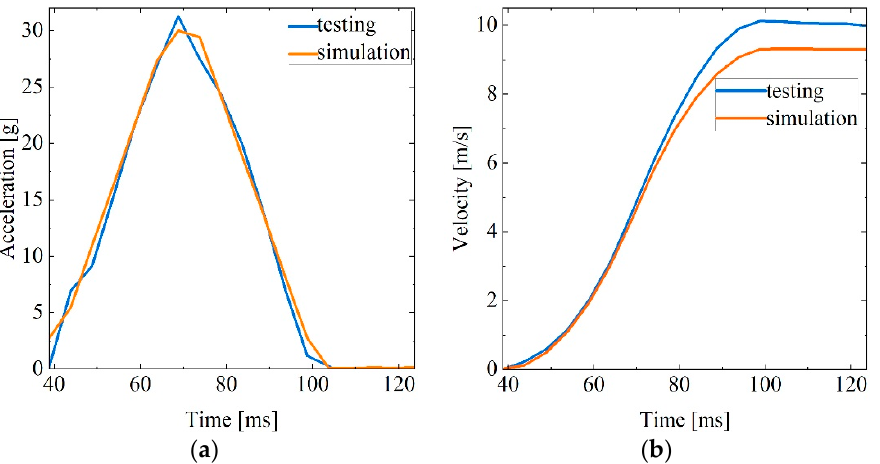
Figure 7. Comparison in terms of acceleration and velocity between the testing and the simulation. ( a ) the comparison of acceleration ( b ) the comparison of velocity.